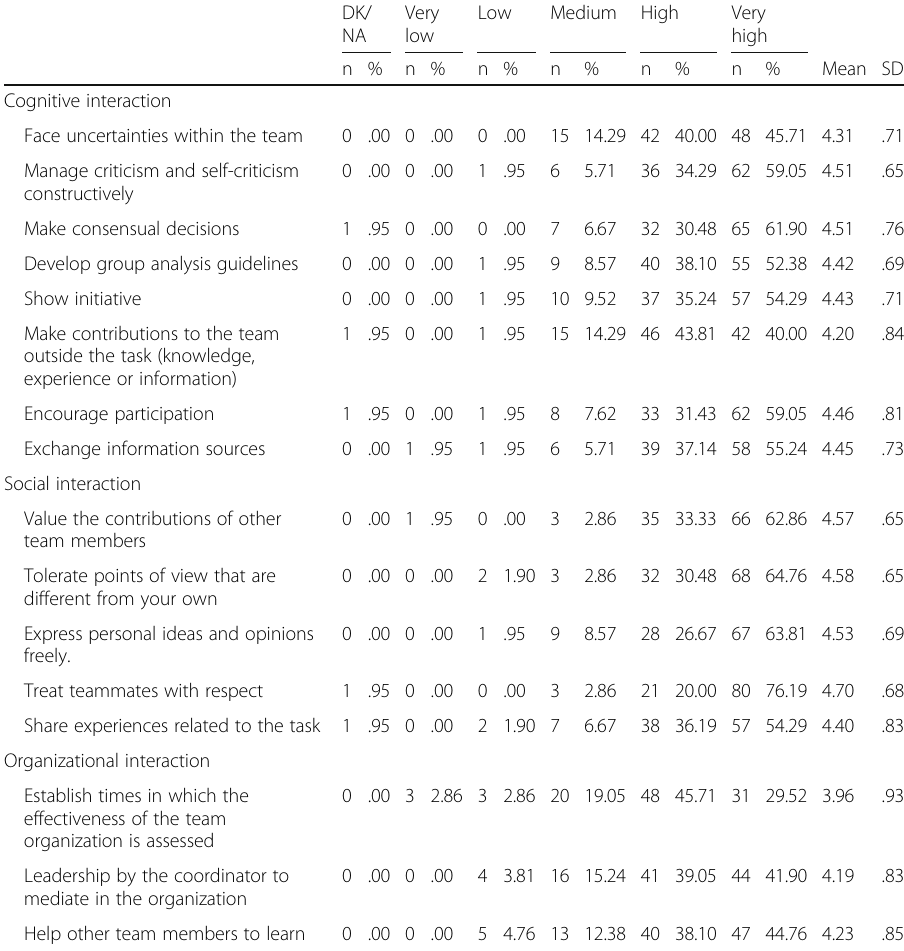
Table 5 Descriptive statistics, means and standard deviations of the items that make up the three types of interactions in CSCL environments